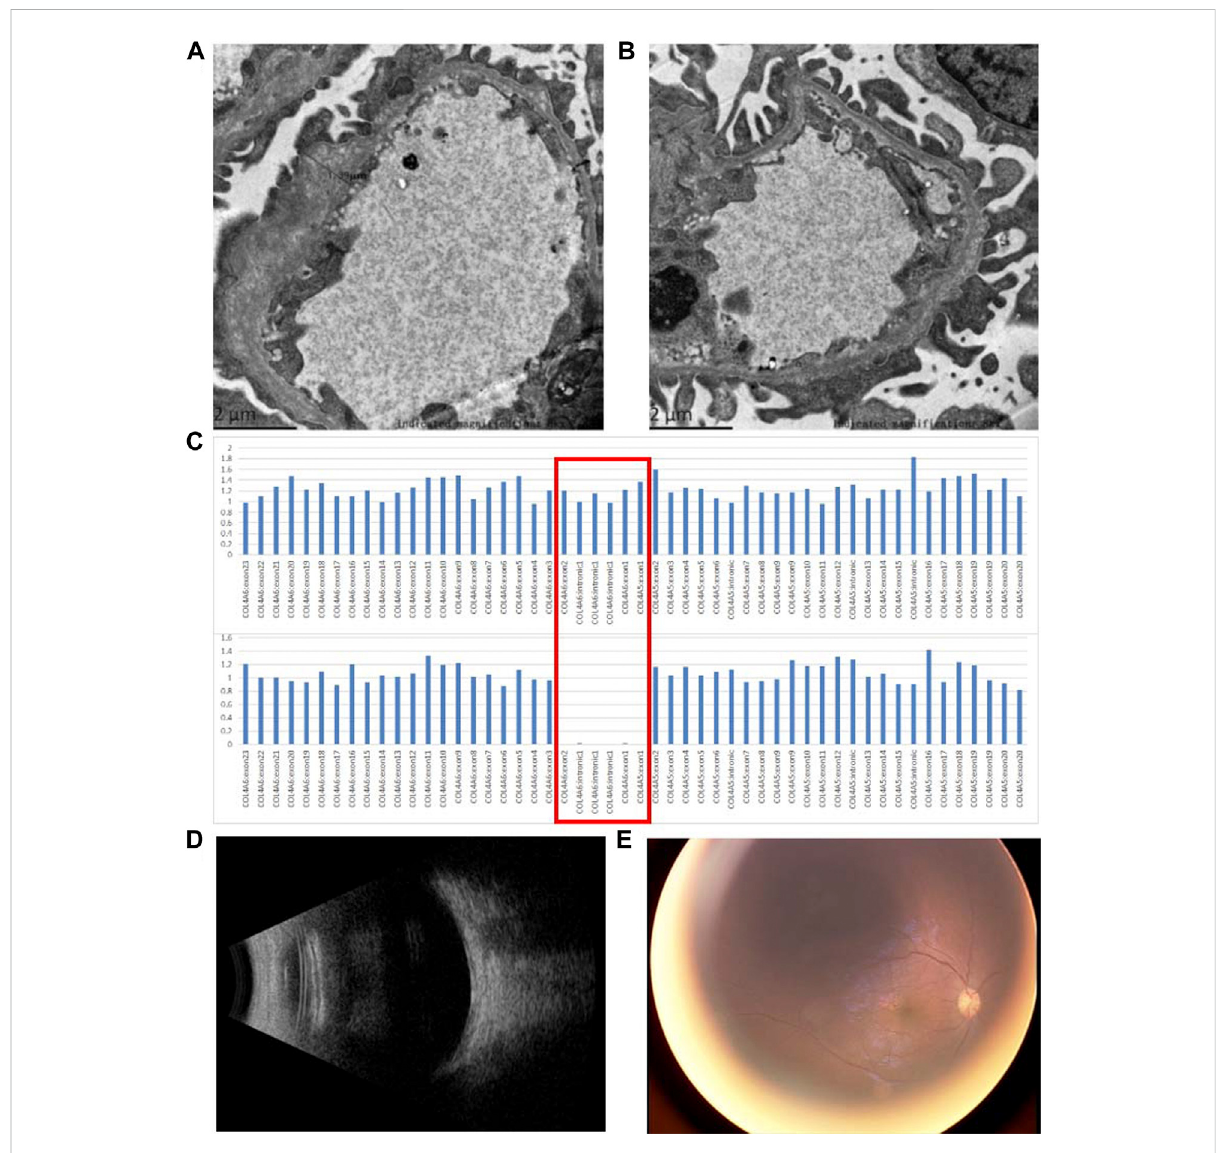
FIGURE 2 Pathologicalandgenetic fi ndingsofthepatientandtheocular fi ndingsafterthetreatmentwithsteroids. (A,B) Electronmicroscopicanalysisofa renal biopsy shows mesangial proliferation and thickening of the glomerular basement membrane (asterisks); (C) WES revealed that a deletion encompassingexon1of COL4A5 andexons1and2of COL4A6 wasfoundinthepatient.Theredboxindicatesexon1of COL4A5 ,intron1,andexons 1 and 2of COL4A6 . The top panel and bottom panelsshow thecopynumber of COL4A5 and COL4A6 from anormal individualand the patient, respectively; (D) B-scan ultrasound reveals a clear vitreous 1 month after treatment with steroids; (E) fundus photography shows resolved vitreous opacity and a clear optic nerve